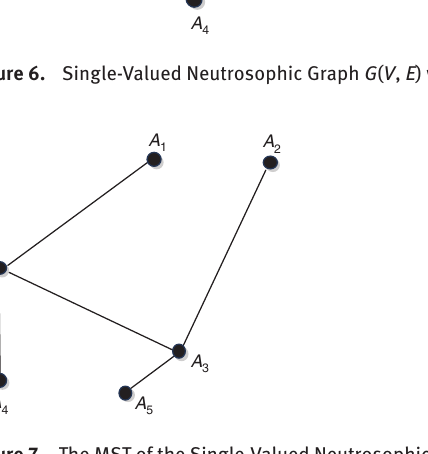
Figure 7. The MST of the Single-Valued Neutrosophic Graph G ( V , E ) with the Six